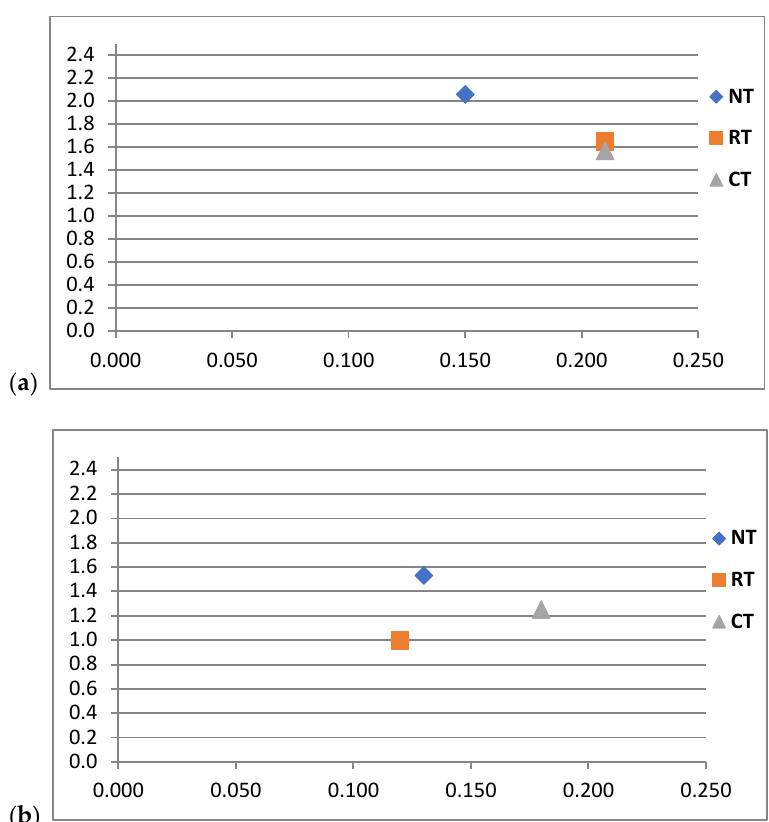
Figure 5. Shannon–Wiener’s diversity ( H’ ) and Simpson’s dominance ( SI ) indices of the weed community in ( a ) pea and ( b ) lupine crop before harvest depending on the tillage system (mean for 2017–2019). NT—no-tillage, RT—reduced tillage, CT—conventional tillage.